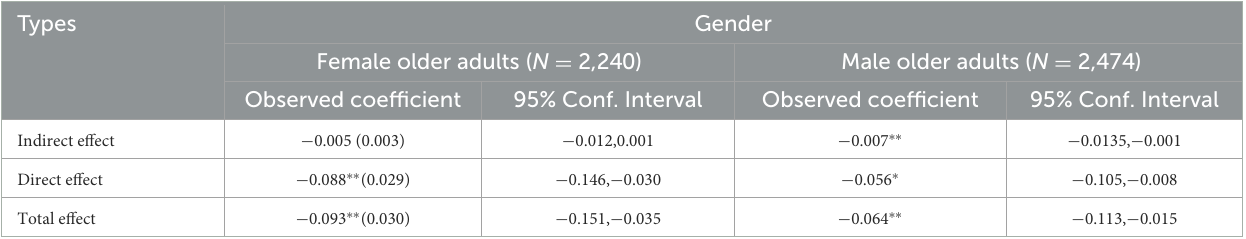
TABLE 7 Results of mediating effect based on samples of female and male older